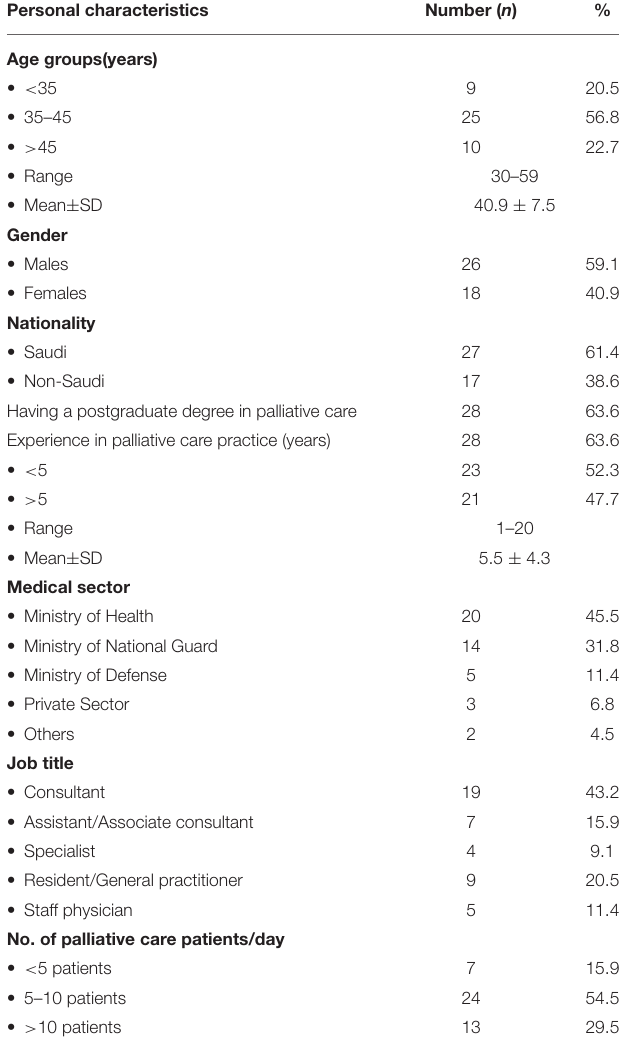
TABLE 1 | Personal characteristics of palliative care physicians.